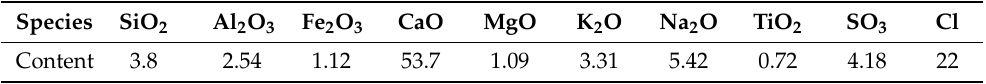
Table 2. Concentration of heavy metals in MSWI fly ash, mg/kg.